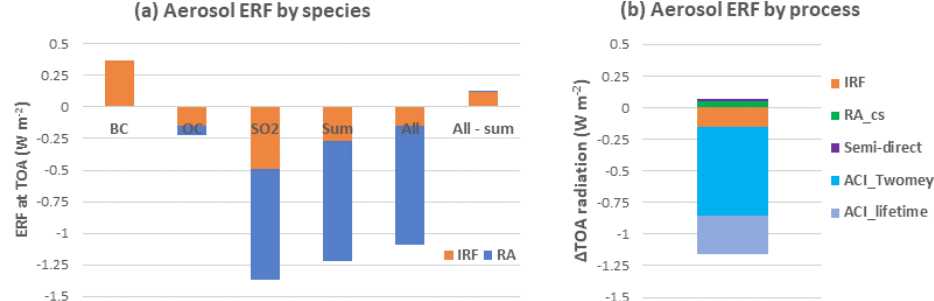
Figure 7. Aerosol ERF broken down by species and process. (a) Results are from piClim-BC , piClim-OC , piClim-SO2 , from summing those three experiments (Sum), and from piClim-aer (All aerosol). (b) Aerosol ERF decomposed into various contributing processes from the piClim-aer and accompanying sensitivity tests: IRF – instantaneous radiative forcing, RA – rapid adjustments, ACI – aerosol–cloud interactions, RA_cs – clear-sky rapid adjustments (e.g. surface albedo, atmospheric temperature, and water vapour). Units in Wm − 2 .